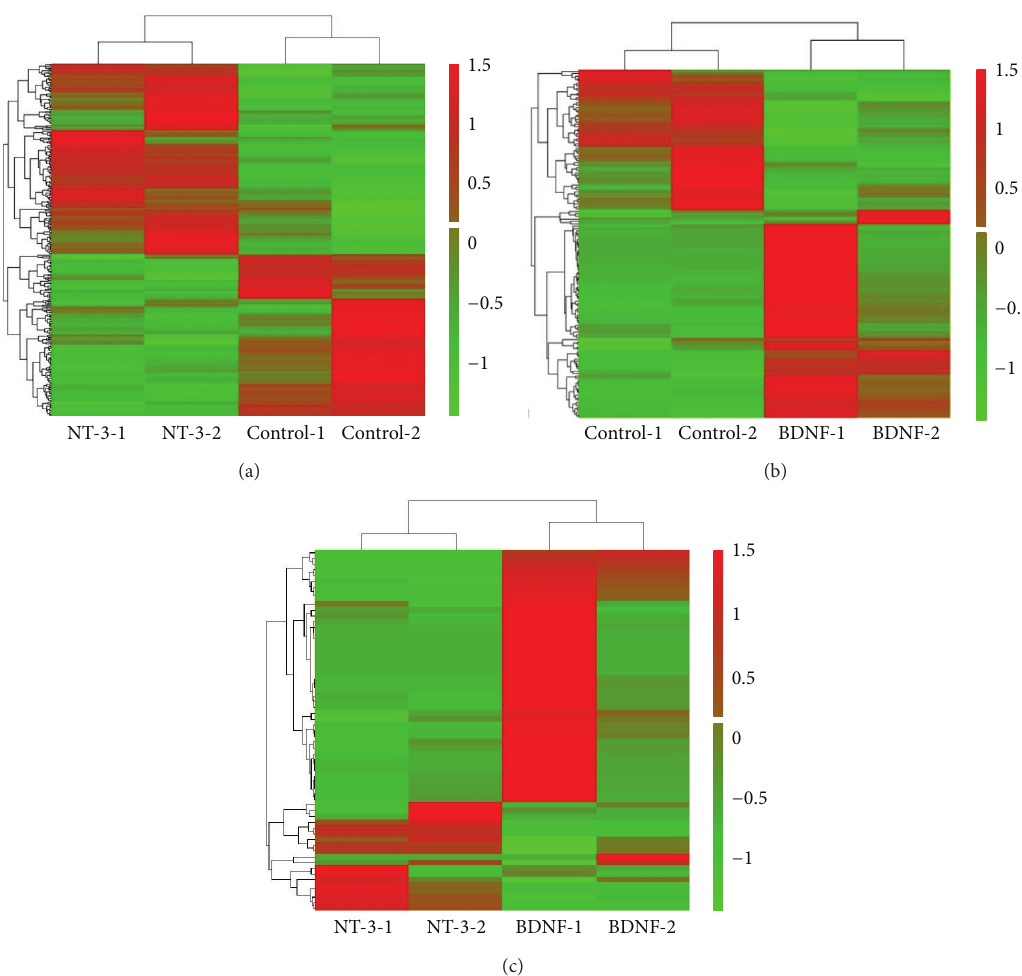
Figure 8: Heat map of the differentially expressed gene set between the different genetic modifications. (a) NT-3 modification and control. (b) BDNF modification and control. (c) NT-3 and BDNF modification.